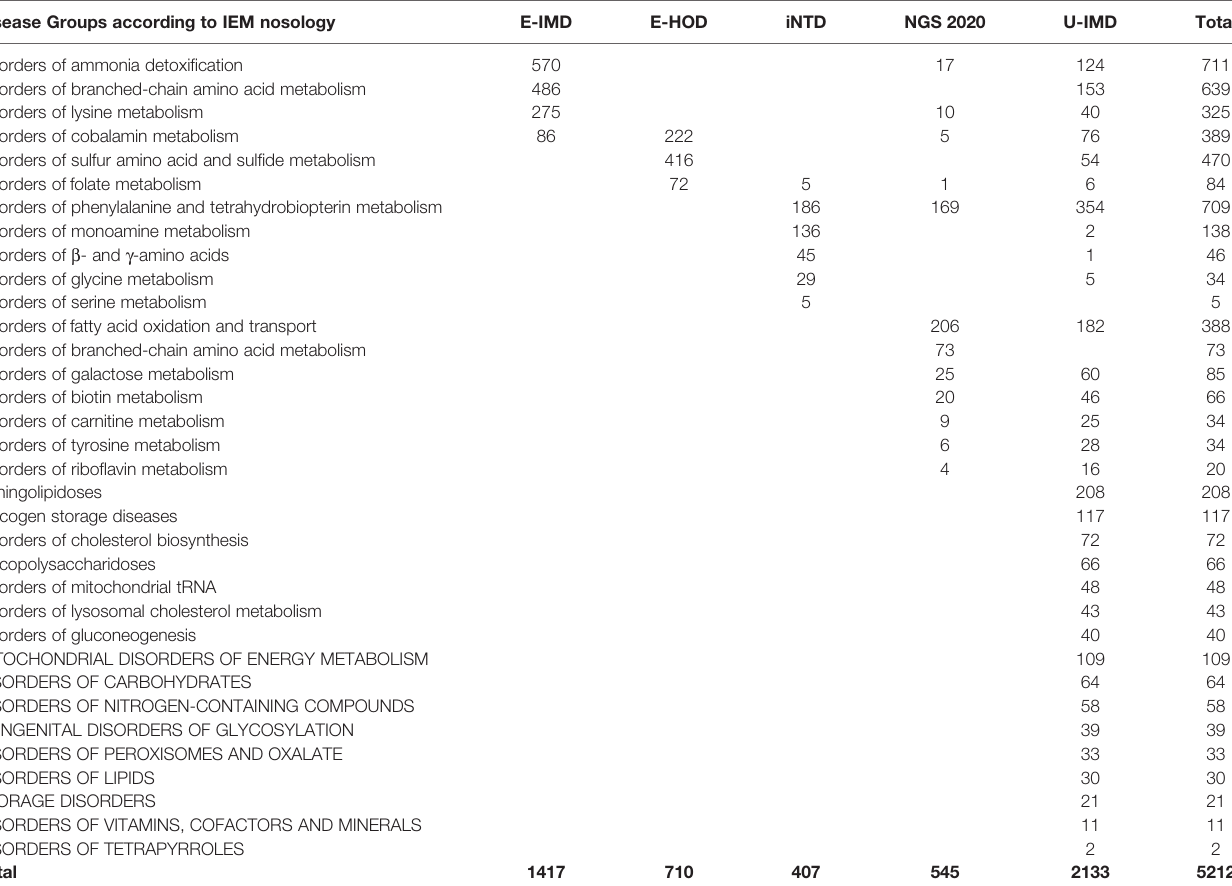
TABLE 1 | Enrolment of active patients for the E-IMD, E-HOD, iNTD and U-IMD registries and for the German newborn screening outcome study (NGS2020, DRKS00013329). Disease Groups according to IEM